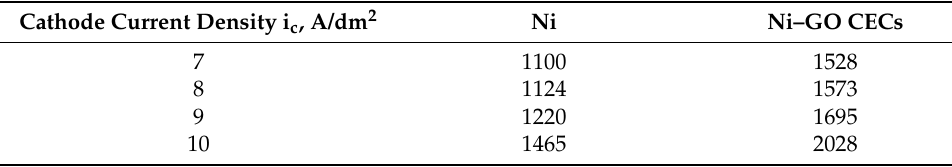
Table 3. Microhardness HV 0.05 values in MPa of nickel coatings.